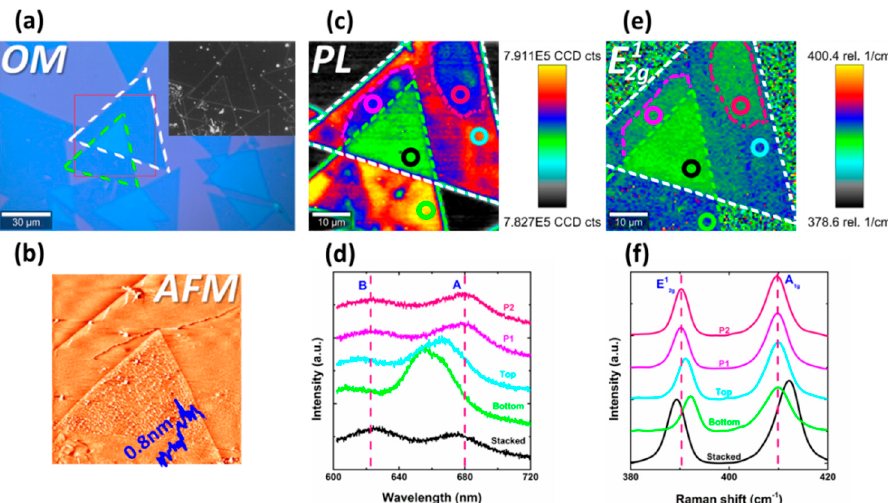
Figure 3. Photoluminescence and Raman inhomogeneity of tBLS. ( a ) Optical micrograph of one tBLS sample. Corresponding dark-field optical micrograph is shown in inset. Bottom and top layers are outlined by green and white dashed lines, respectively. Red box defines the scanning area of (c,e). ( b ) AFM micrograph of the same sample in (a). ( c ) PL intensity map. ( e ) Raman shift map of mode E 1 ( d , f ) PL and Raman spectra of different regions. These regions are labeled by circles in corresponding colors in (c,e).